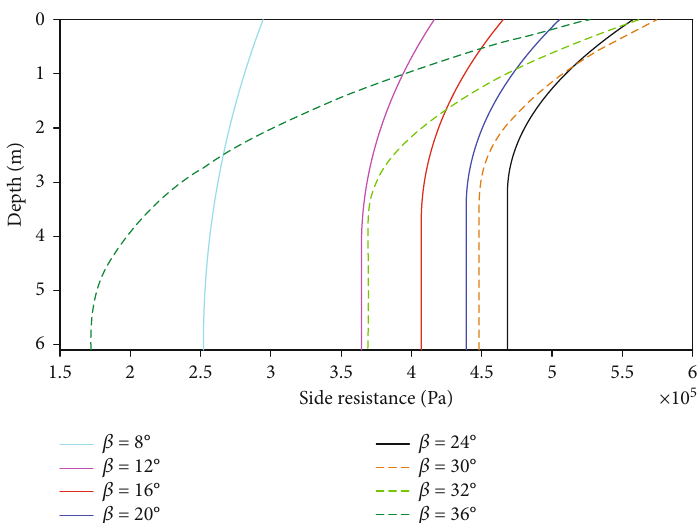
Figure 9: The in fl uence of dilation angle on dilation unit side resistance.